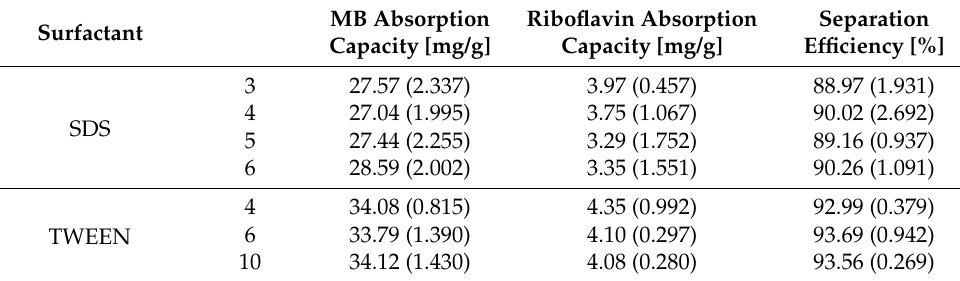
Table 3. Results of the absorption experiments, standard deviation in brackets.